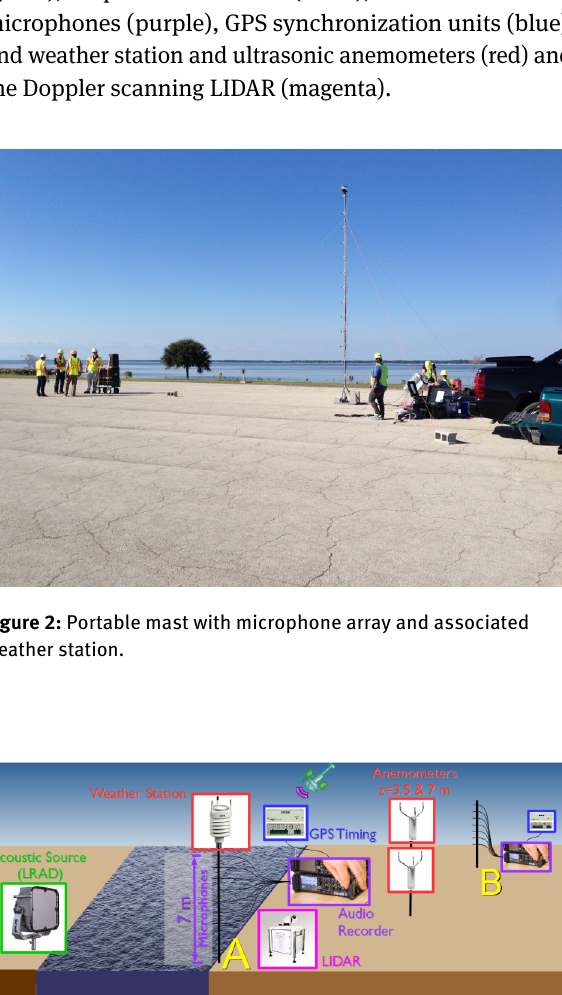
Figure 1: Excess attenuation model results for homogeneous and inhomogeneous wind speed profiles along a propagation range.